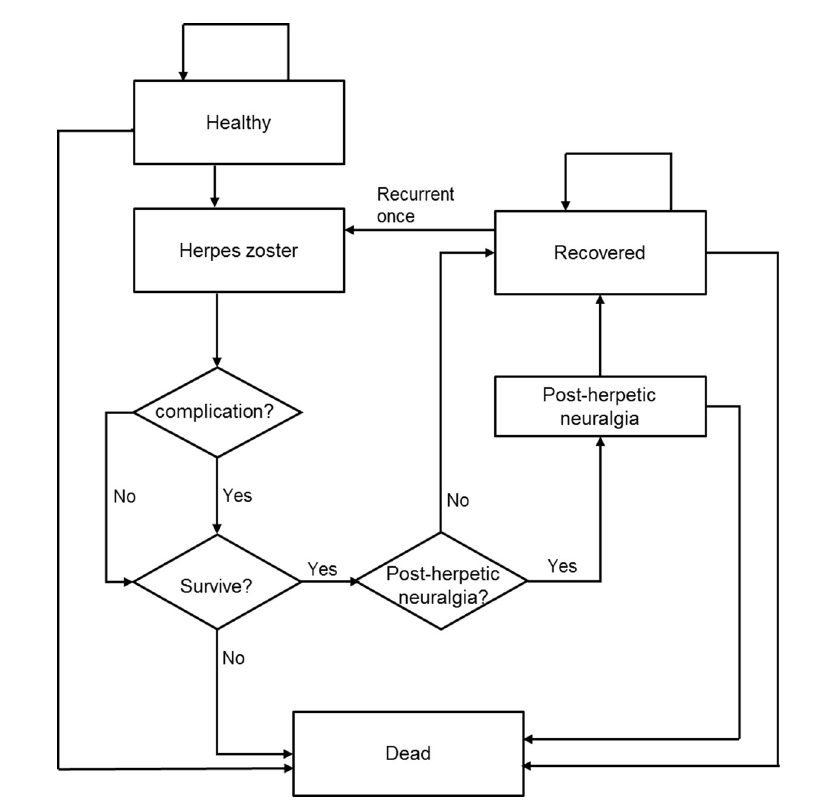
Fig 1. Markov diagram of herpes